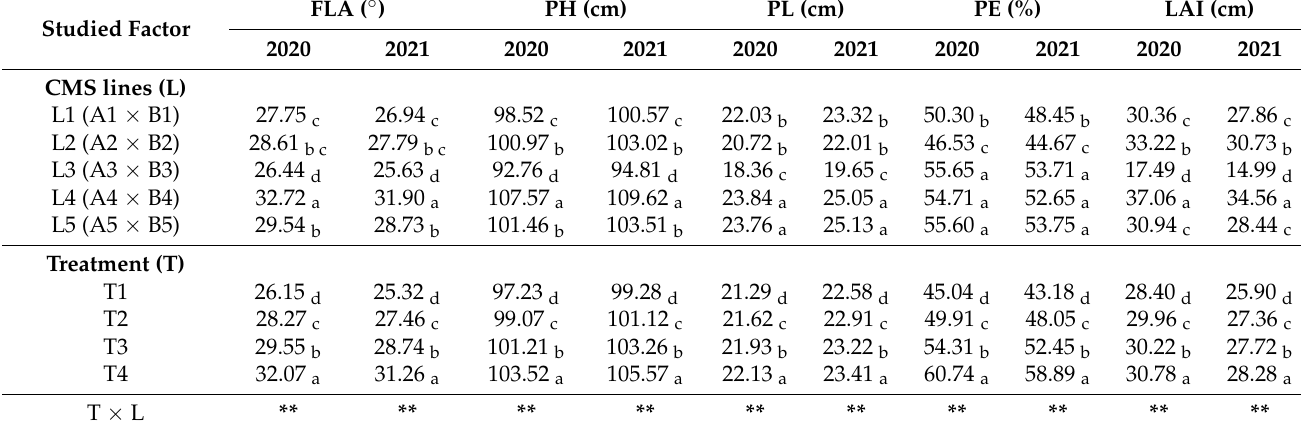
Table 4. The impact of cyanobacteria application on the flag leaf angle (FLA), plant height (PH), panicle length (PL), panicle exertion (PE), and leaf area index (LAI) of CMS lines. The table represents the mean performance of CMS lines under all treatments (upper part) and the mean performance of treatments in all CMS lines (lower part) regarding growth-related